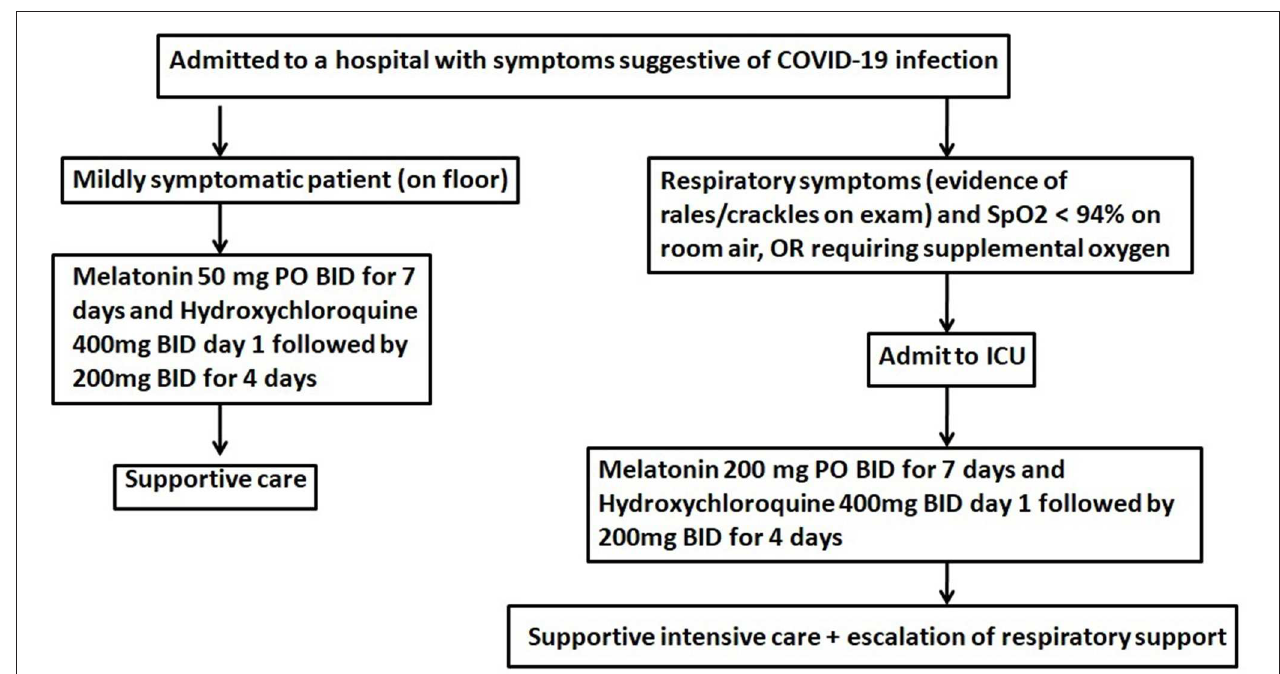
FIGURE 2 | Therapeutic algorithm for use of melatonin in patients with COVID-19. Melatonin will likely reduce the toxicity of chloroquine and increase its efficacy. BID, twice daily; PO, per oral.